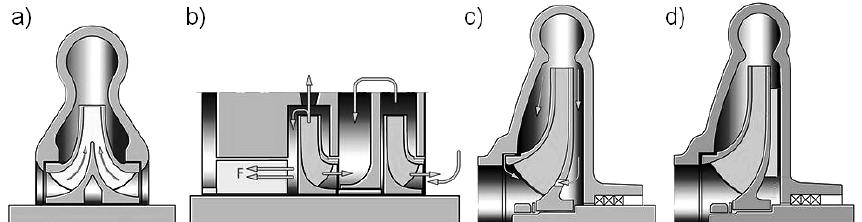
Figure 22. Different measures to balance axial thrust: ( a ) double suction impeller, ( b ) balancing drum, ( c ) balance holes, and ( d ) back vanes. Reproduced from [168], KSB Pumps: